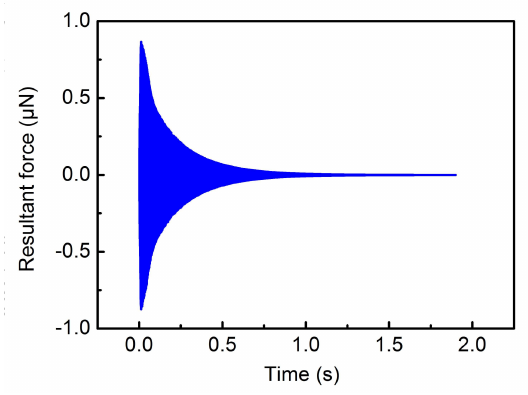
Figure 8. The resultant force of Coriolis force and feedback